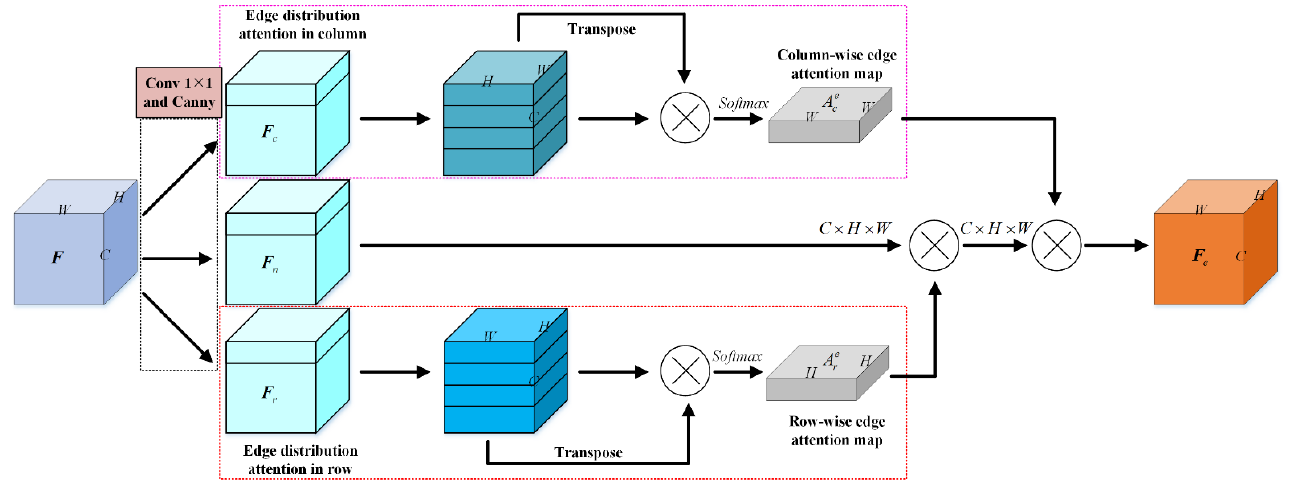
Figure 3. Pipeline of EDA.